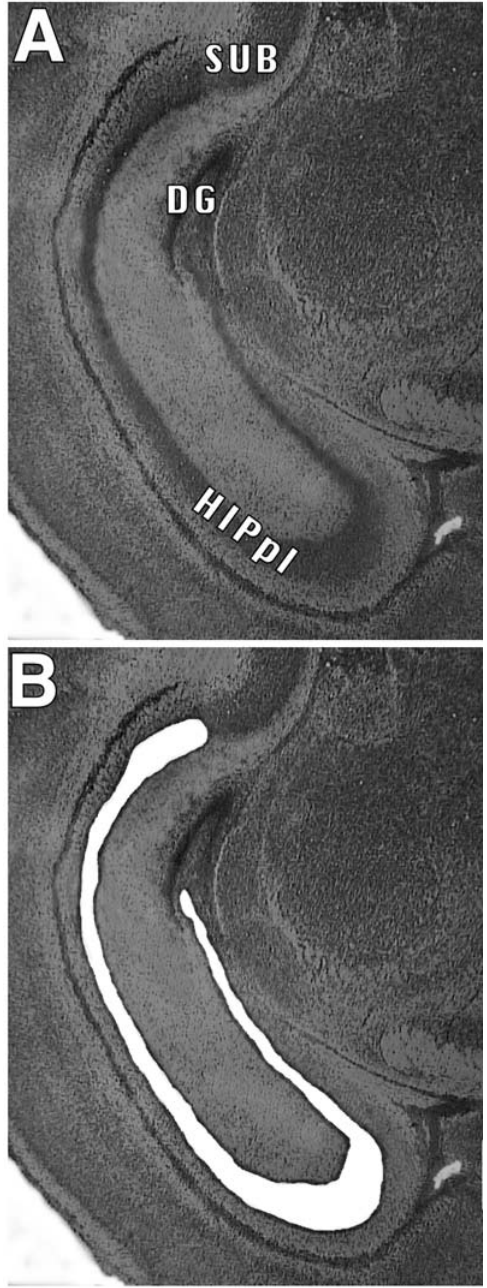
Figure 2. Histology of hippocampal sections before and after laser microdissection. Photomicrograph of a typical HistoGene- stained coronal section through the hippocampus of a 3-day-old mouse (a), and the same section following excision of the hippocampal pyramidal layer by microdissection on a Leica ASLMD laser capture microdissection system (b) . HIPpl, hippocampal pyramidal layer; DG, dentate gyrus; SUB, subiculum. Note the precision of the cut. doi:10.1371/journal.pone.0001919.g002 campal pyramidal layers of male P3 pups born to cocaine-treated females compared with matched pups from saline-control dams.